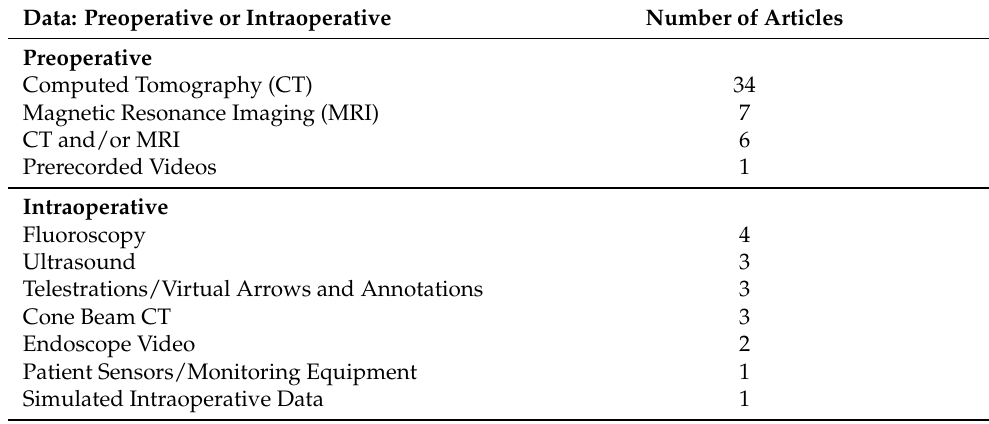
Table 2. Papers categorized by the data type they employed. Some articles included a combination of preoperative and intraoperative